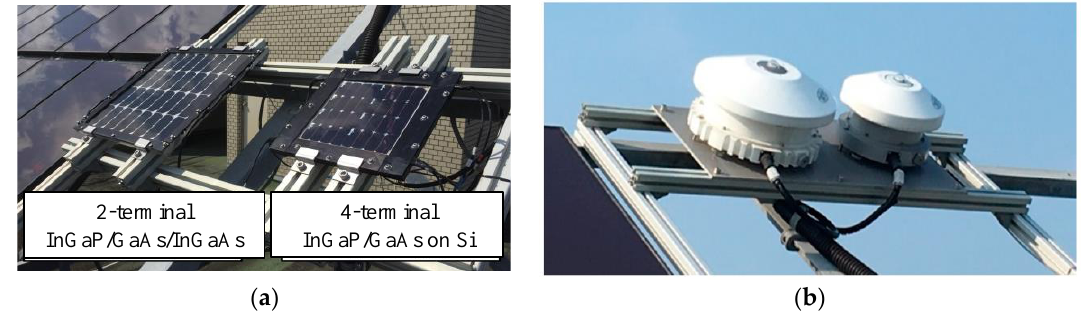
Figure 2. Measured 4T III-V/Si module and its solar cell structure: ( a ) Description of measured 4T III-V/Si module, 2 + 1 junctions (right) with comparison to the 2-terminal III-V 3-junction module. Note that the number of junctions is the same; ( b ) Spectro-radiometers [97].